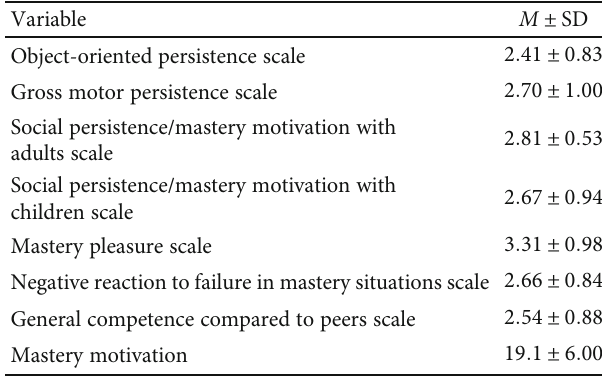
Table 1: Subjects of the study ( N = 99 ). Table 2: Mastery motivation of subjects ( N = 99